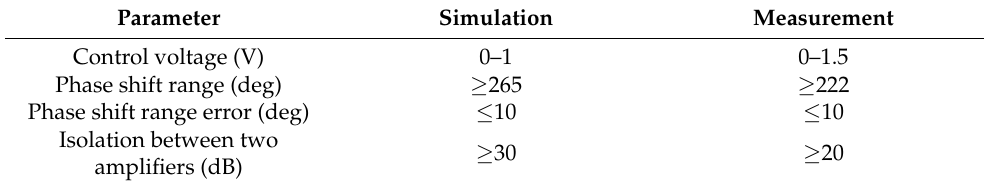
Figure 21. The maximum amplitude/phase error and calculated isolation between two amplifiers: ( a ) Maximum amplitude error of four output ports; ( b ) Maximum phase error of four output ports; ( c ) The calculated average isolation through maximum amplitude and phase error, respectively. Table 1. The comparison between simulation and measurement of the designed six-port chip. Parameter